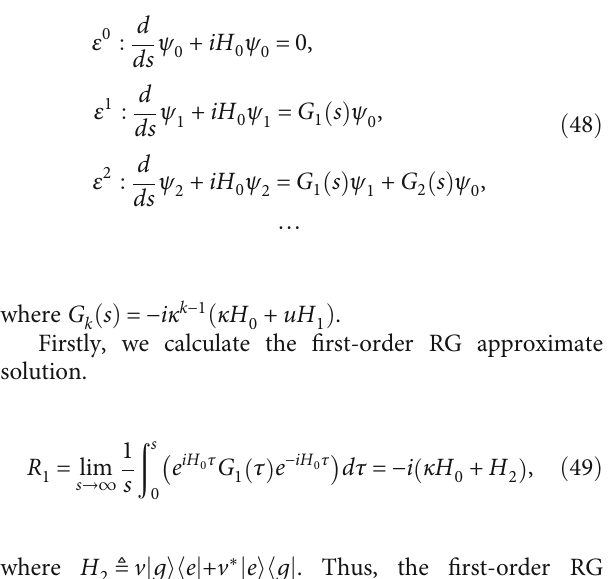
Figure 2: RG vs. Runge-Kutta approximate solutions of two-level systems out of